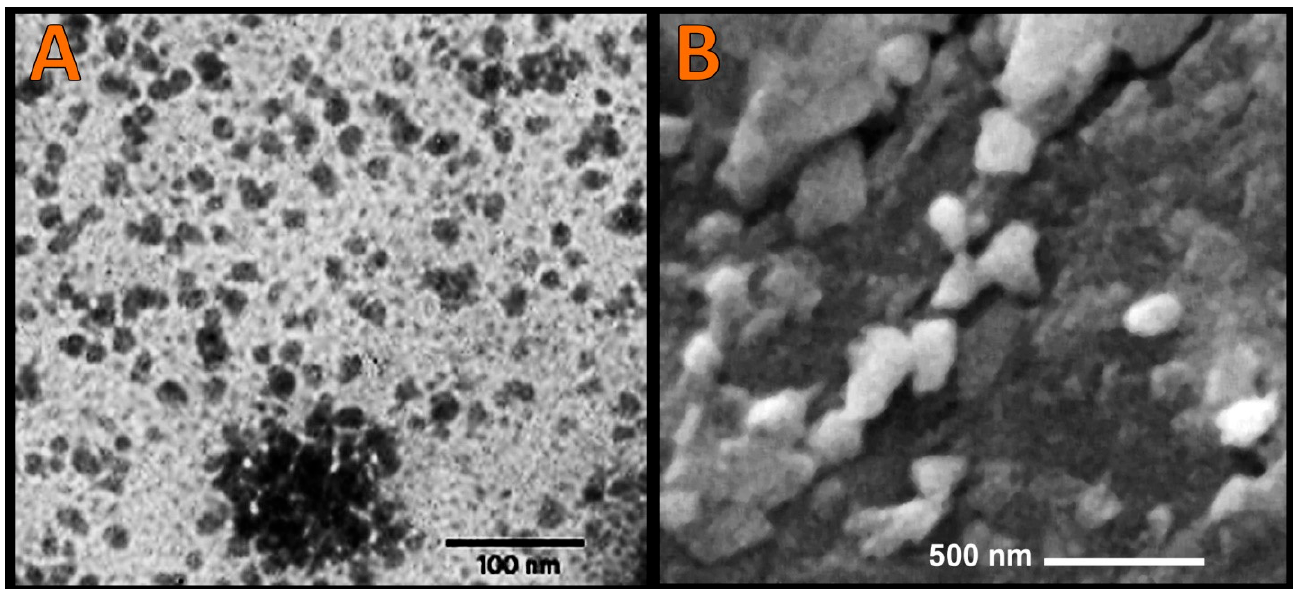
Figure 4. Ultrastructure of synthesized nanoparticles, including ( A ): transmission image of propolis-synthesized SeNPs and ( B ): scanning image of bee chitosan nanoparticles. Table 1. Nanoparticles’ size and charges of fabricated bee nanochitosan (BNCt), propo- lis-synthesized SeNPs (Pro-SeNPs) and their nanocomposites (BNCt/Pro/SeNPs). Nanoparticles